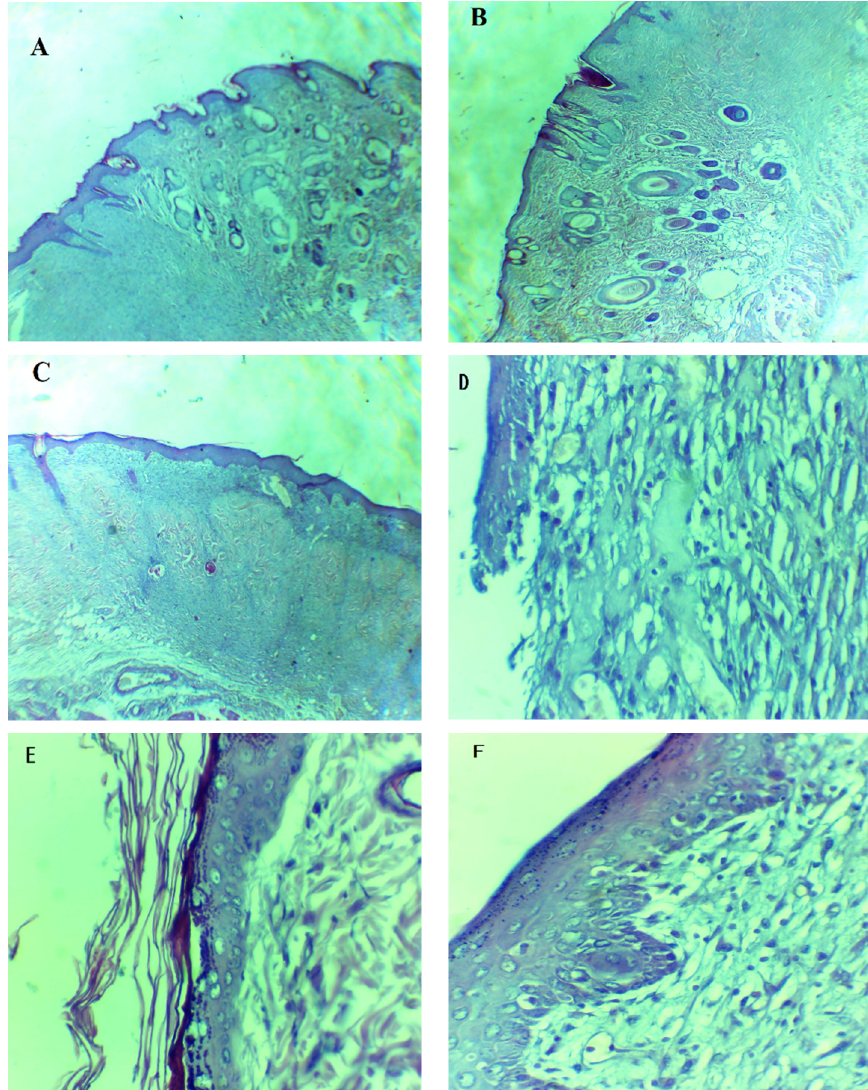
Figure 10. Hematoxylin- and eosin-stained burned epithelial tissues of rats for histopathological analysis. ( A , D ) are tissues from the control group, ( B , E ) are tissues from the marketed drug-treated group and ( C , F ) are tissues from the formulation-treated group. ( A – C ) = 5×, ( D – F ) = 40×.